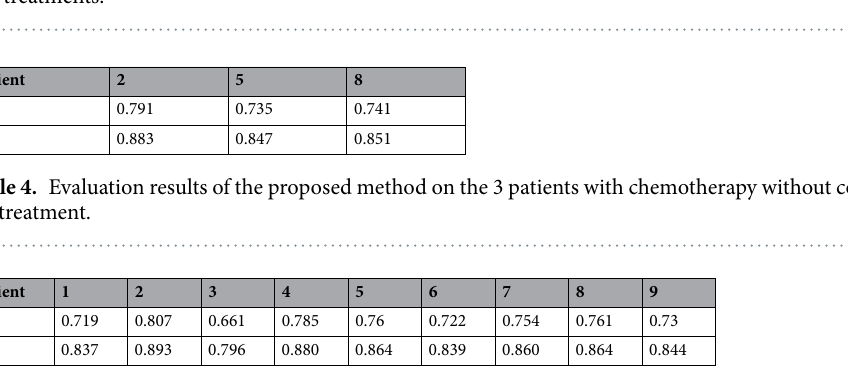
Table 5. Evaluation results of the proposed method on the 9 LGG patients under study using JS and DC without including